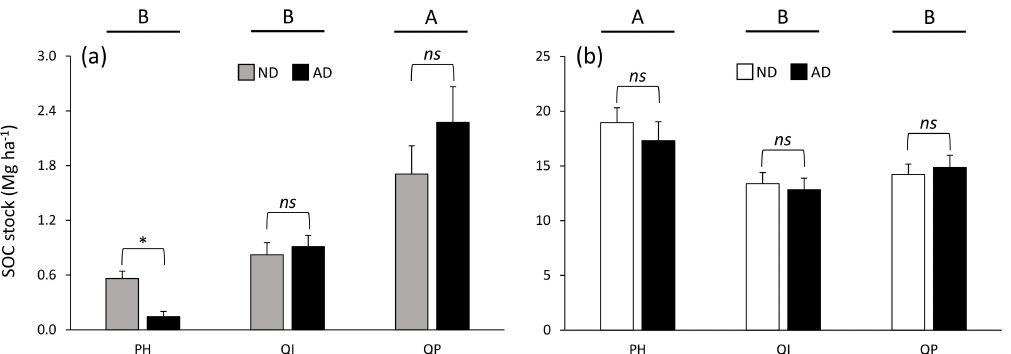
Figure 5. Soil organic carbon stock in soil ( a ) organic and ( b ) organo–mineral layer according to the significant forest type × precipitation treatment × soil layer interaction (Table 3). Data are mean values ± SE and expressed as Mg per ha; n = 15. Different capital letters denote significant differences between forest types for each soil layer with A > B (post hoc Tukey tests results). Stars indicate significant differences between precipitation treatments (* for P < 0.05). SOC—soil organic carbon, ND—natural drought, AD—amplified drought, PH— Pinus halepensis , QI— Quercus ilex , QP— Quercus pubescens .